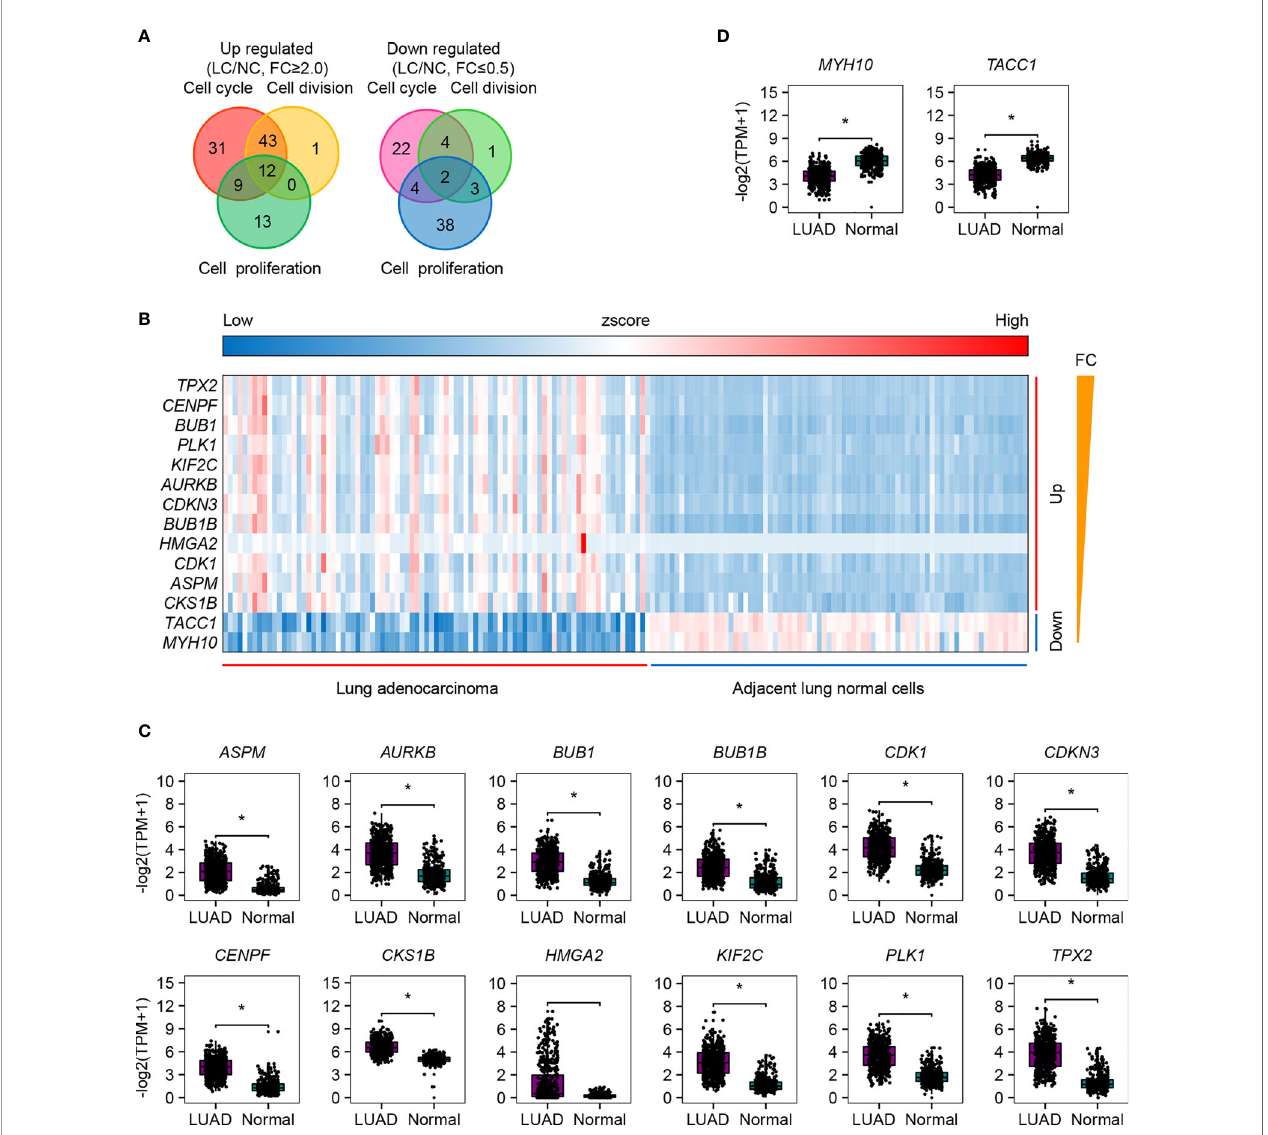
FIGURE 2 | The up- and downregulated genes that are involved in cell cycle, cell division, and cell proliferation. (A) Venn diagram plot of the up- and downregulated genes that are involved in cell cycle, cell division, and cell proliferation. (B) Heatmap of the 12 upregulated and 2 downregulated genes involved in all the above three processes. (C) Expression validation of the 12 upregulated DEGs by GEPIA2. Reads box is the expression of LUAD samples; gray box is the expression of normal samples. (D) Expression validation of the two downregulated DEGs by GEPIA2. Reads box is the expression of LUAD samples; gray box is the expression of normal samples. *p.adj ≤